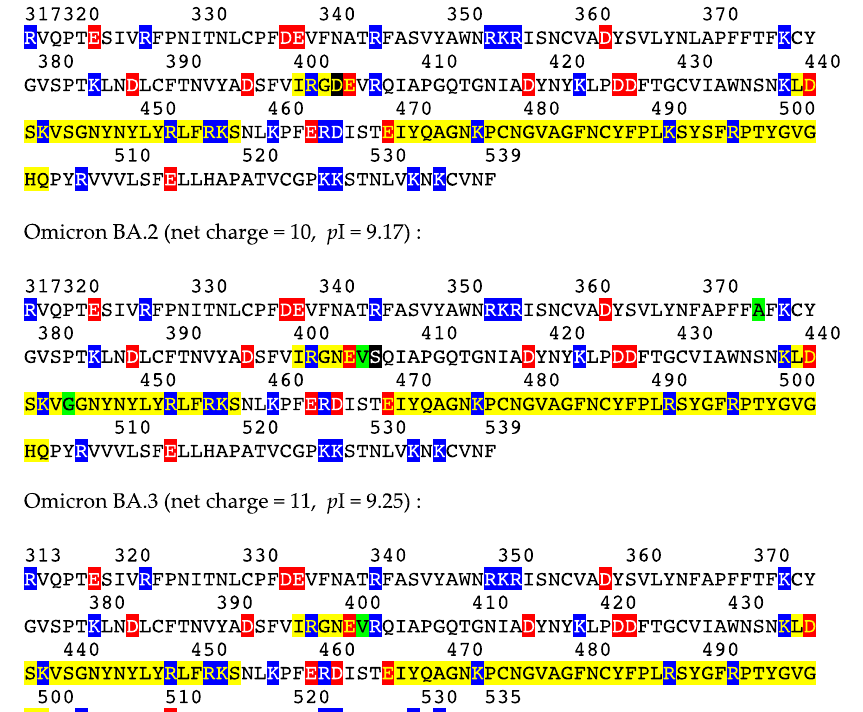
bility. As shown in Figure 5, electropositively and electronegatively charged residues are Figure 4. Figure illustrating the relationship between the increasing effective reproduction number similarly distributed in the three lineages, except for BA.1, which contains an additional D403 residue, and BA.2, which lacks a R406 residue (replaced by S406 residue). In addi- (E.R.N.) of the α , β , γ , κ , δ and o variants of concern and their increasing isoelectric point ( p I) values. tion, a few amino acid changes in the RBDs of BA.2 (A374, V405, G444) and BA.3 (V401) Mapping of electropositive potentials (blue) on the molecular surface of the VOC is represented. The lineages have generated hydrophobic residues susceptible to reduce the interaction be- E.R.N. of omicron variant was arbitrarily fixed at +120% because it is too early to have an accurate tween the spike protein and the ACE2 receptor. estimation of its E.R.N., especially in Europe and in USA (?).